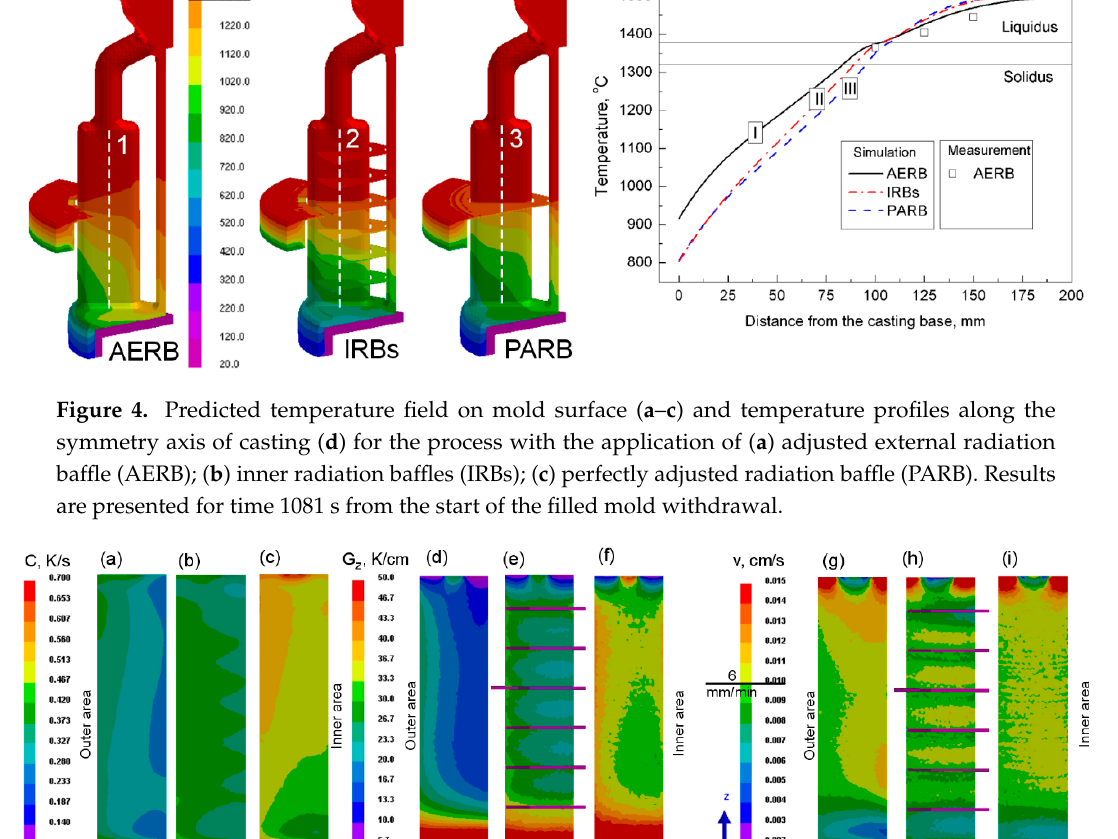
Figure 5. Predicted cooling rate ( a – c ), axial temperature gradient ( d – f ), and solidification rate ( g – i ) along the casting height. AERB: adjusted external radiation baffle; IRBs: inner radiation baffles; PARB: perfectly adjusted radiation baffle.